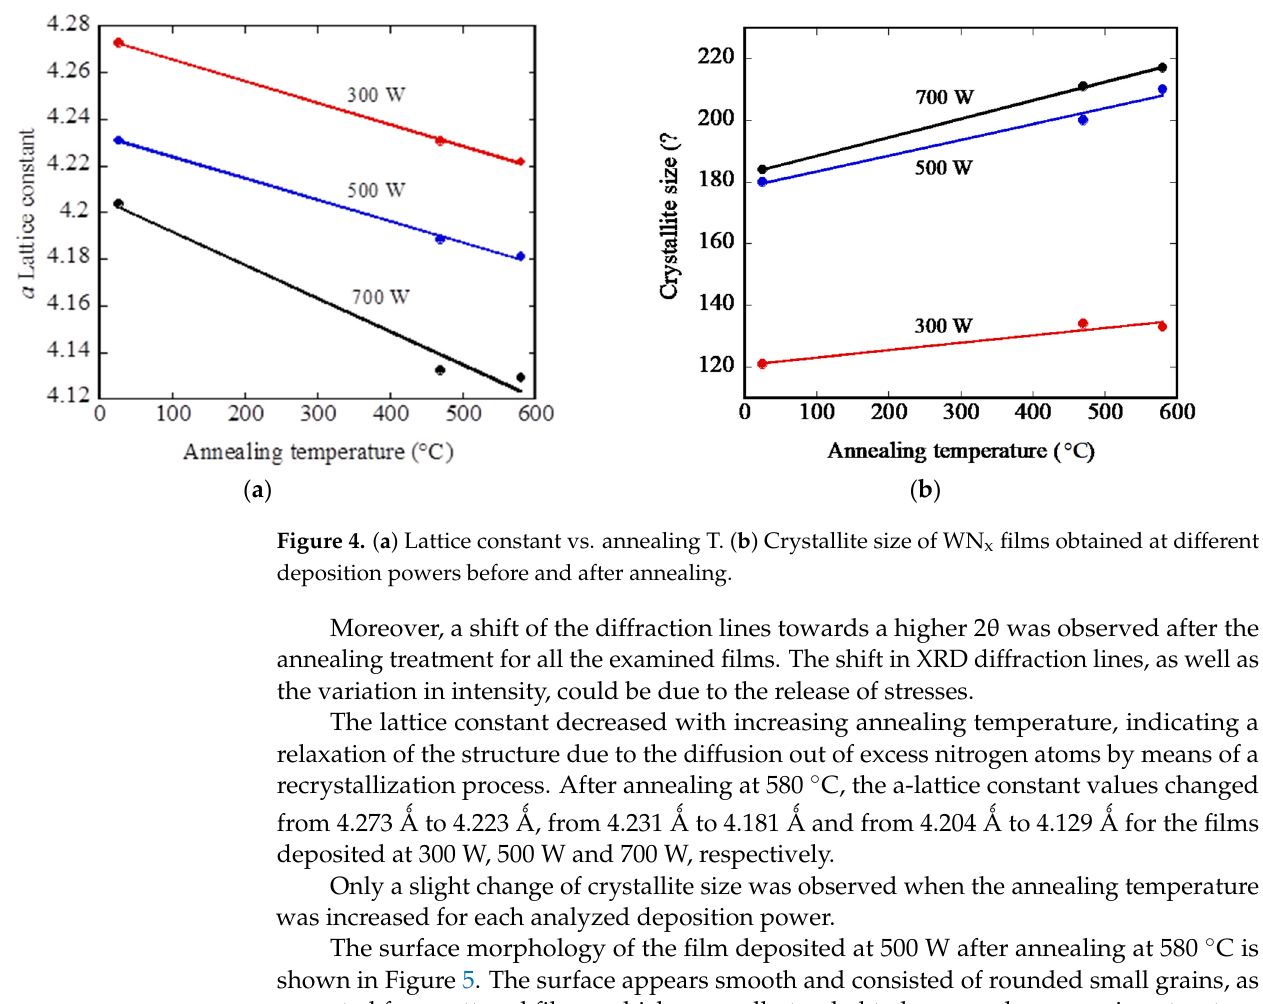
( b ) Figure 6. AFM pictures of 700 W WN x films, ( a ) as deposited and ( b ) annealed at 580 °C. For metal nitrides that crystallize in cubic structures and ideal “perfect” crystals, first ‐ order Raman scattering is forbidden because there is translational symmetry, q = 0, and all atoms are in centrosymmetric octahedral sites [18]. Nevertheless, sputtered coat ‐ ings are known to have vacancies that induce distortion in the structure and, as a con ‐ sequence of this, the Raman spectrum is composed of broadened bands due to disorder and second ‐ order processes. In analyzed samples there was Raman activity, so no stoi ‐ chiometric cubic nitrides were present. Lattices were expanded by the effect of nitrogen adsorption. The Raman spectra of the as ‐ grown films reported in Figure 7 had three main regions: 